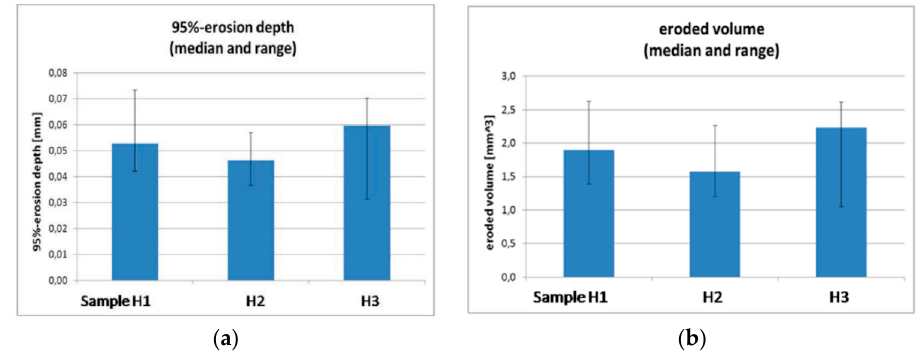
Figure 29. ( a ) PD erosion depth and ( b ) PD erosion volume for unfilled XLPE (sample H1), XLPE/5 wt % unfunctionalized nanoSiO 2 (sample H2) and XLPE/5 wt % functionalized nanoSiO 2 (sample H3) (© 2016 IEEE. Reprinted, with permission, from [24]).